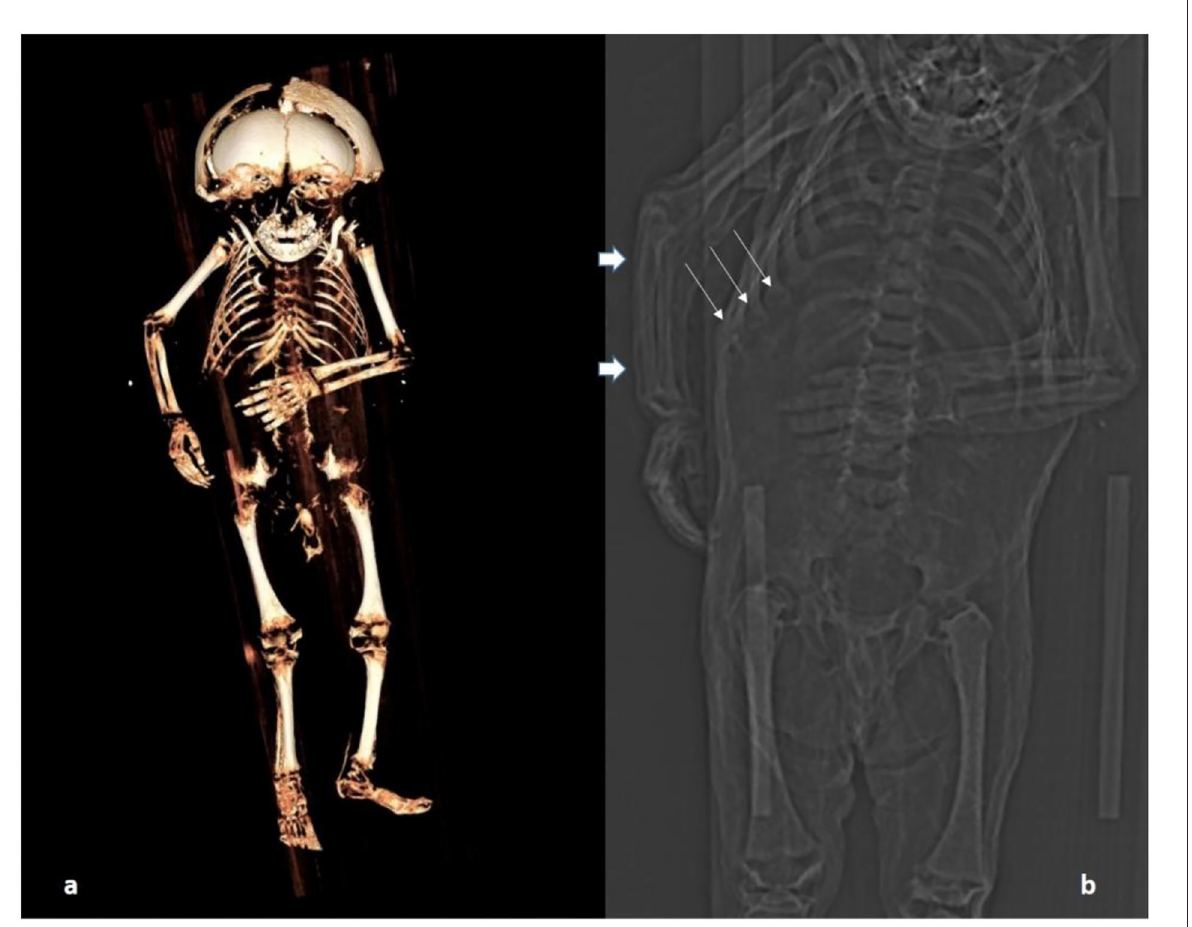
FIGURE4 CT scan of the body: (a) Three-dimensional reconstruction of the skeleton. (b) A section of the topogram showing particularly the rosary of the costochondral junction (thin arrows); long bones are straight (possibly the right ulna is very slightly bent; thick arrows) and the metaphyses are minimally enlarged at upper and lower long